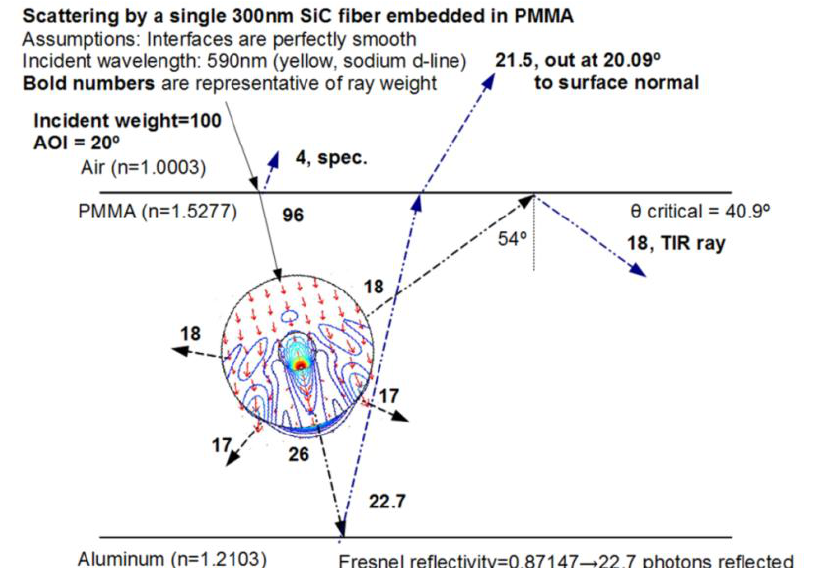
Figure 7. Pictorial summary of a hybrid light scattering simulation of a simple discrete material, a 300 nm diameter SiC fiber embedded in